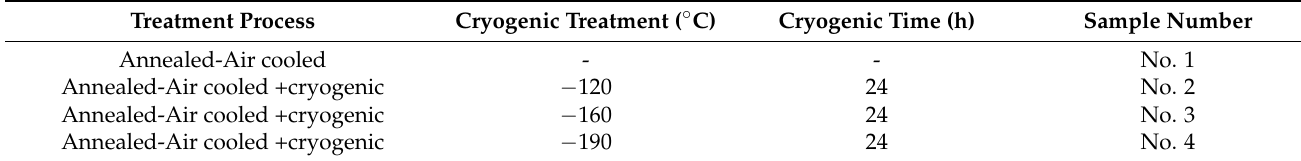
Table 2. Process name and